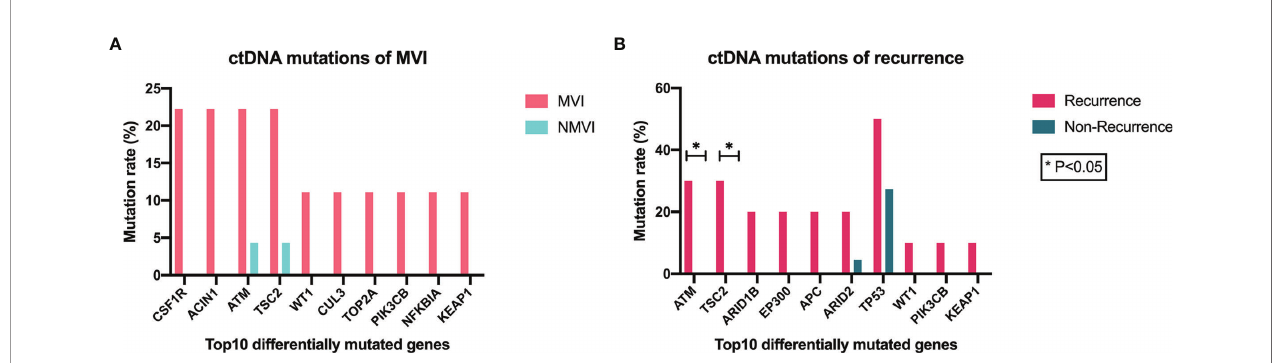
FIGURE 5 | Association between genomic alterations of ctDNA and MVI or recurrence status. (A) Top 10 differentially mutated genes sorted according to p -value between MVI and NMVI groups. (B) Top 10 differentially mutated genes sorted according to p -value between recurrence and non-recurrence groups.